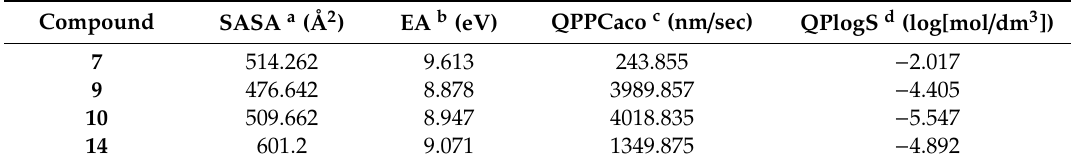
Table 3. Physical and pharmacokinetic properties of active pyrrolo[3,2- d ]pyrimidines.